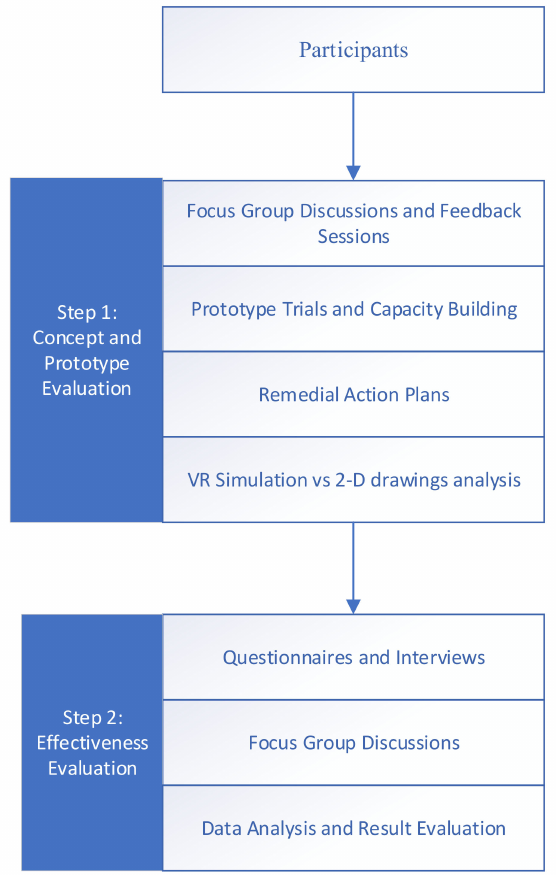
Figure 5. Evaluation